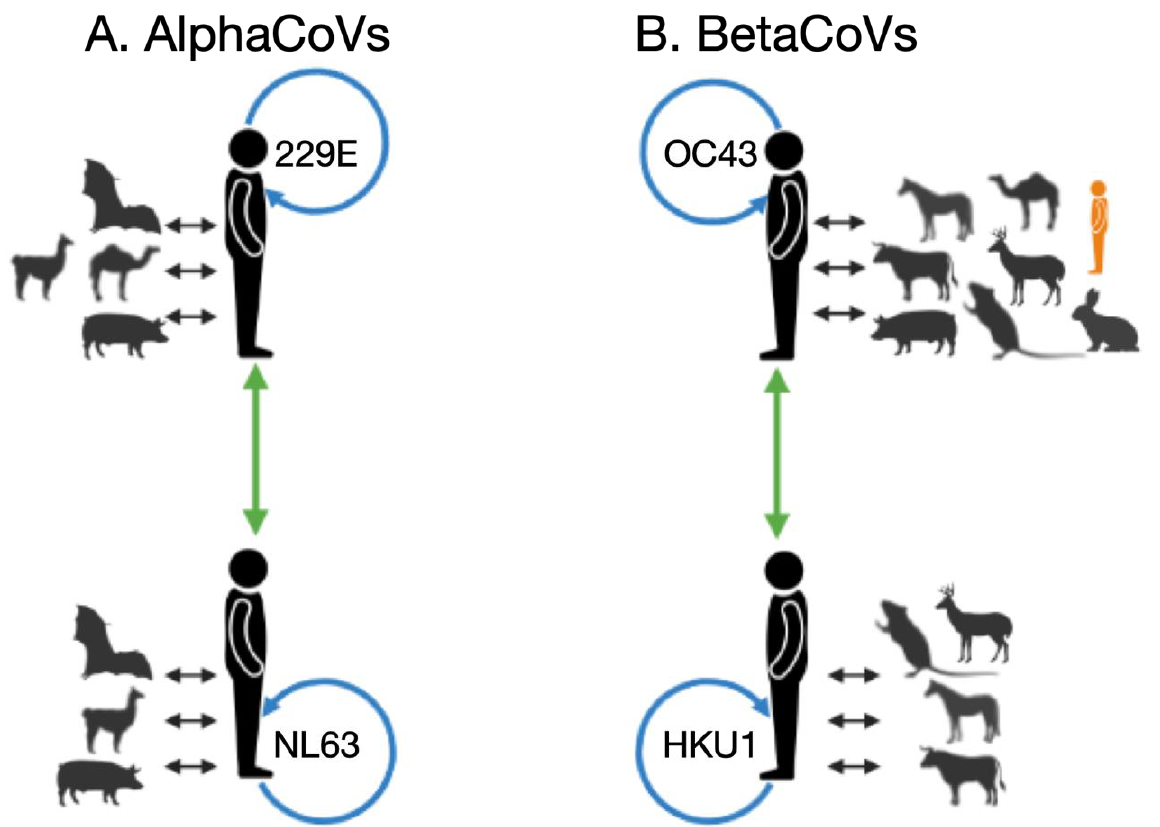
Figure 4. Summarized within and between host/species recombination patterns identified by RDP4, for alphaCoVs ( A ) and betaCoVs ( B ). For each sHCoV species, recombining CoVs are shown; non- human and sHCoV (black arrows), within sHCoV species (blue arrows), and between sHCoV species (green arrows). In orange is a lone human CoV (FJ415324) that clusters with ungulate and canine CoVs. Figure generated using Biorender.